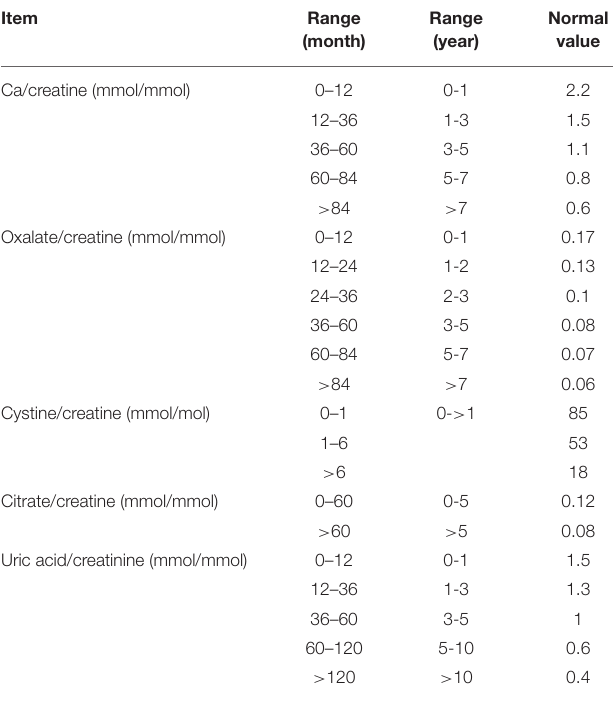
TABLE 1 | Cut-off levels of solute:creatine ratios in relation to age group (12). Item